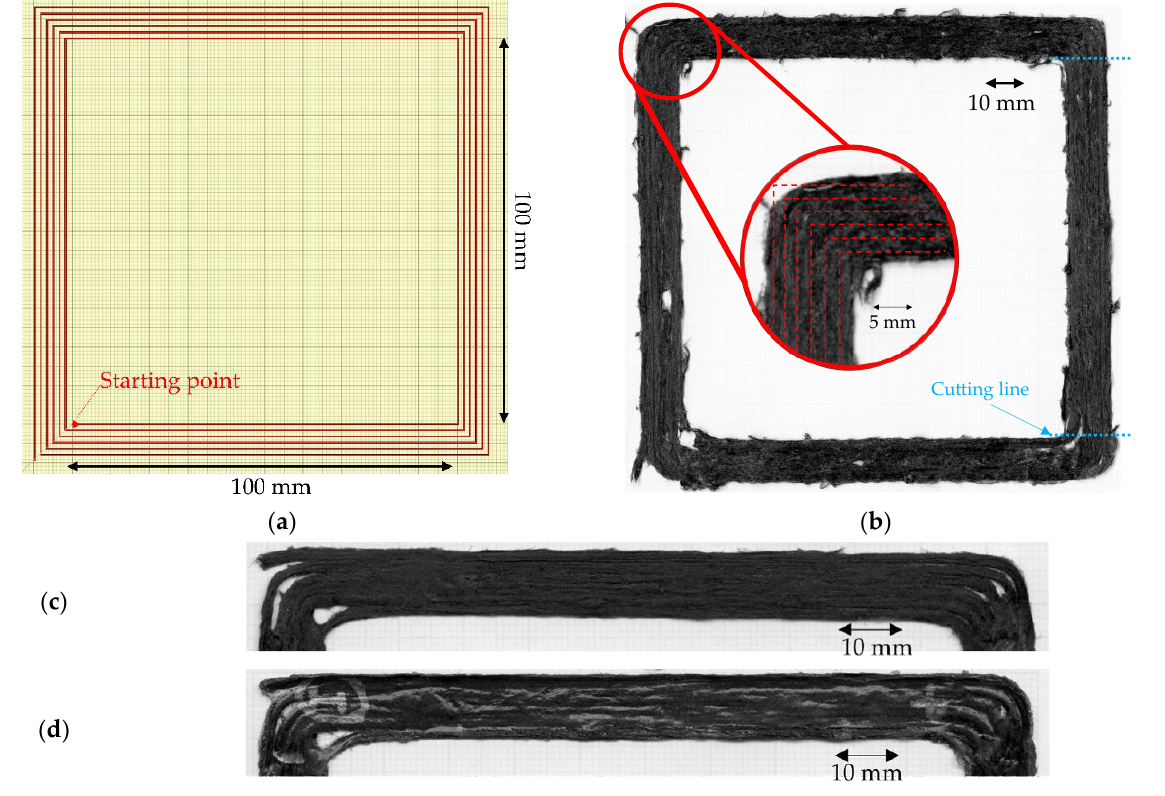
Figure 5. ( a ) Printing path of large square shape with 90° sharp turning corners to produce four tensile samples starting from inside; ( b ) top surface of the sharp corner printed part with a zoom-in of a corner [25]; ( c ) high magnification of the large square as printed; ( d ) high magnification of the large square printed after post-printing consolidation.